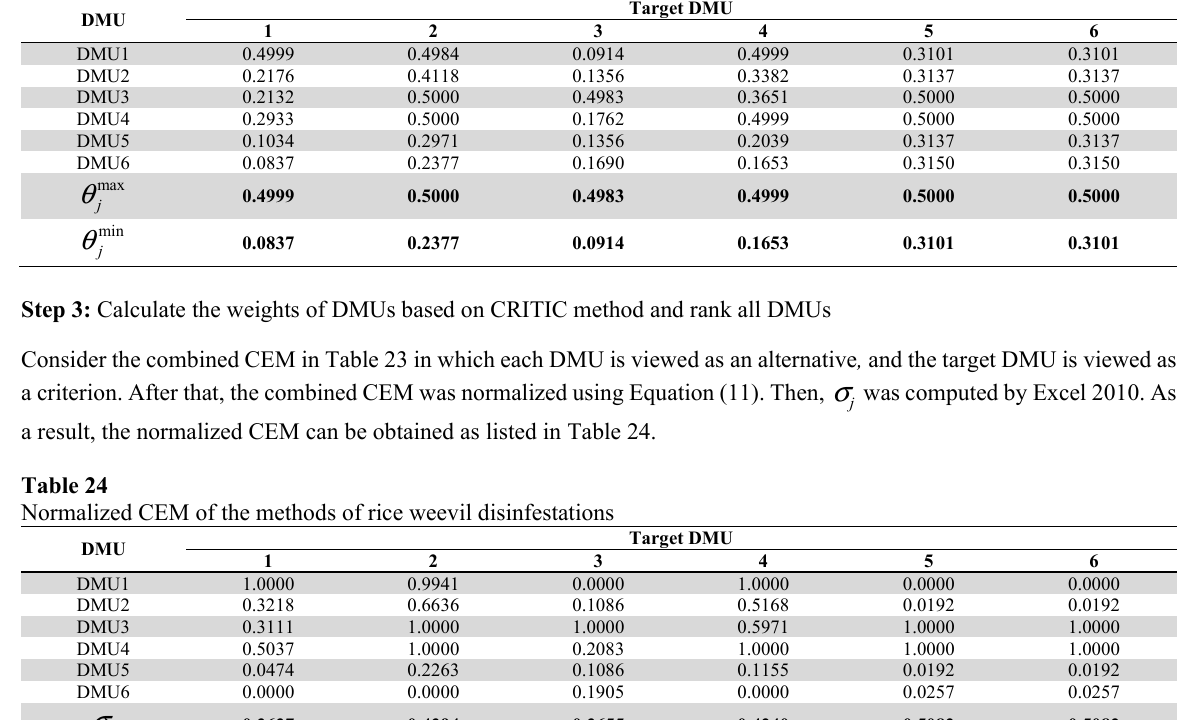
Step 2: Combine the Ideal CEM and Anti-Ideal CEM using the new formula After obtaining Ideal and Anti-Ideal CEMs, using Equations 8 to 10, the combined CEM can be obtained as listed in Table 23. Combined CEM of the methods of rice weevil disinfestations